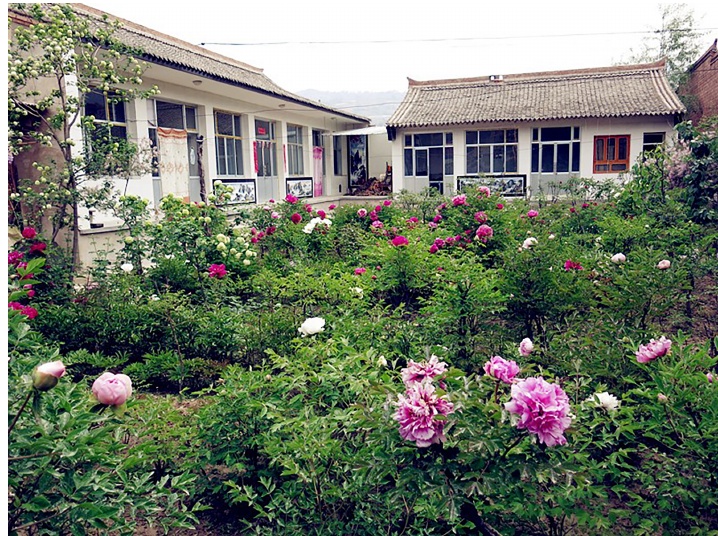
Figure 5. A Courtyard with Peony, Hezhou City (Photo by Zhou Chuanbin, 2014). A common peasant courtyard almost occupied by a flower bed through which one can see the love of peony in northwest